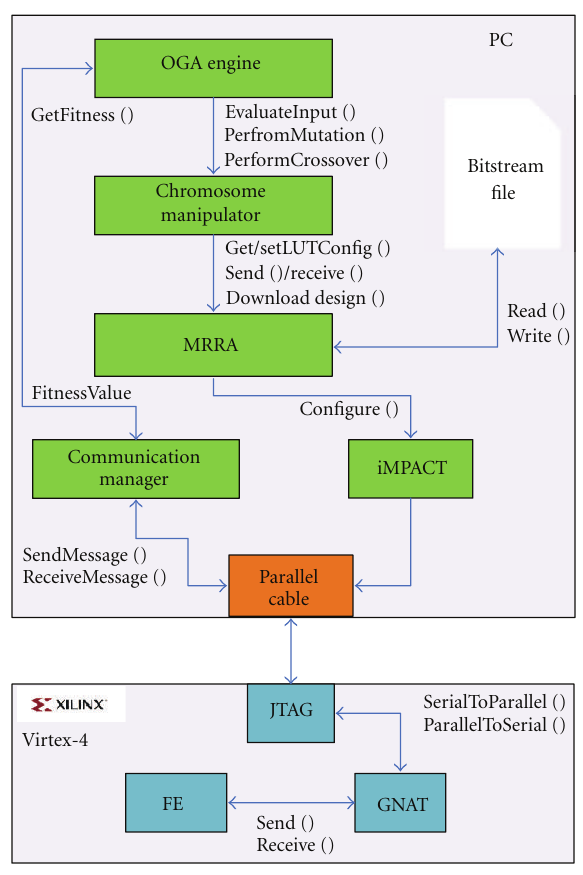
Figure 5: Intrinsic evolution